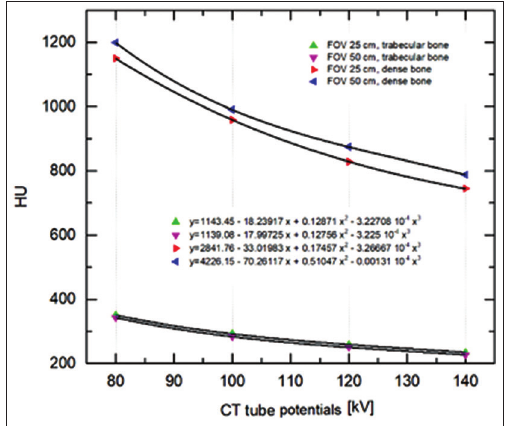
FIGURE 5. Decrease in Hounsfield units value with increasing tube potentials for trabecular and dense bone, for field of view size 25 cm and 50 cm.